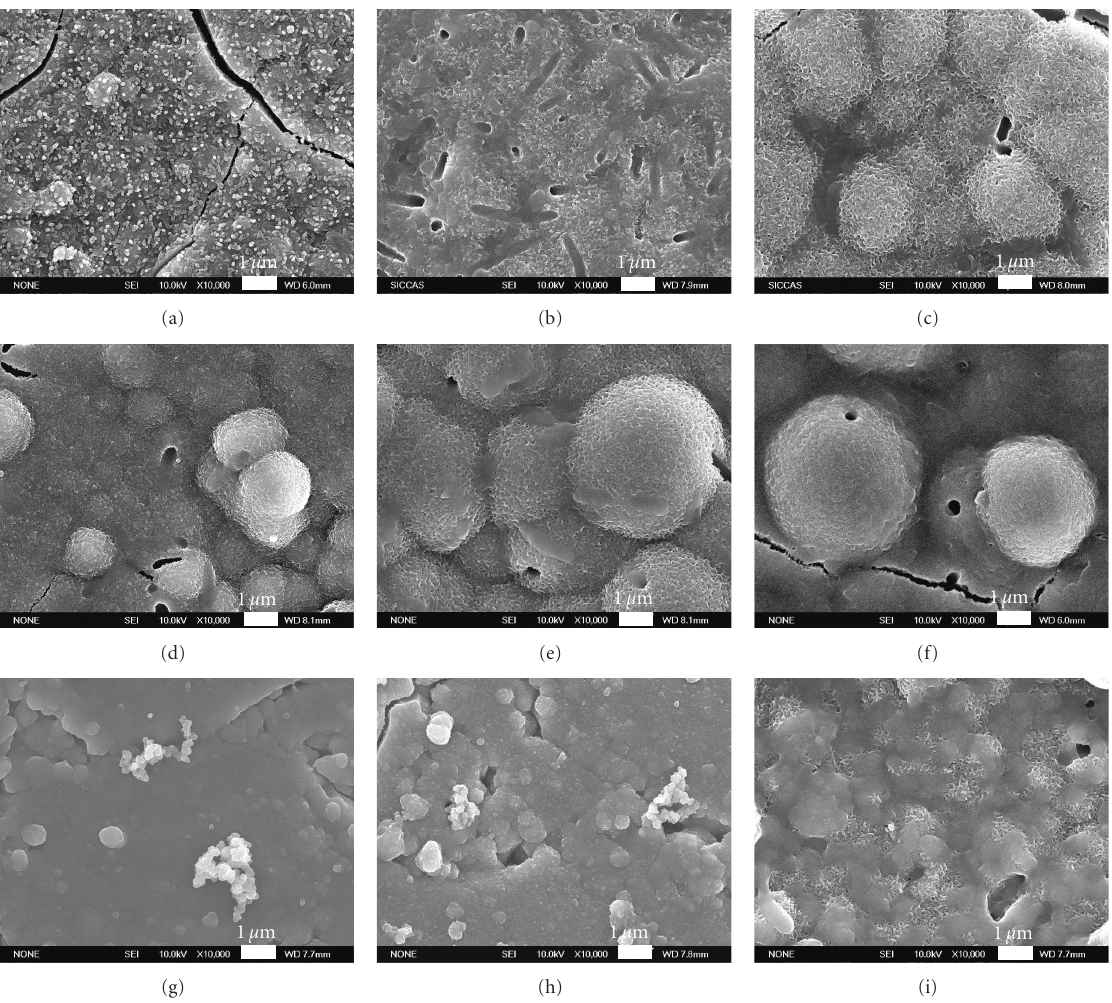
Figure 6: SEM micrographs of the surfaces of 58S ((a), (b), (c)), 58S6N ((d), (e), (f)), and 58S6T ((g), (h), (i)) after immersion in SBF for 1 ((a), (d), (g)), 3 ((b), (e), (h)), and 5 ((c), (f),( i)) days,